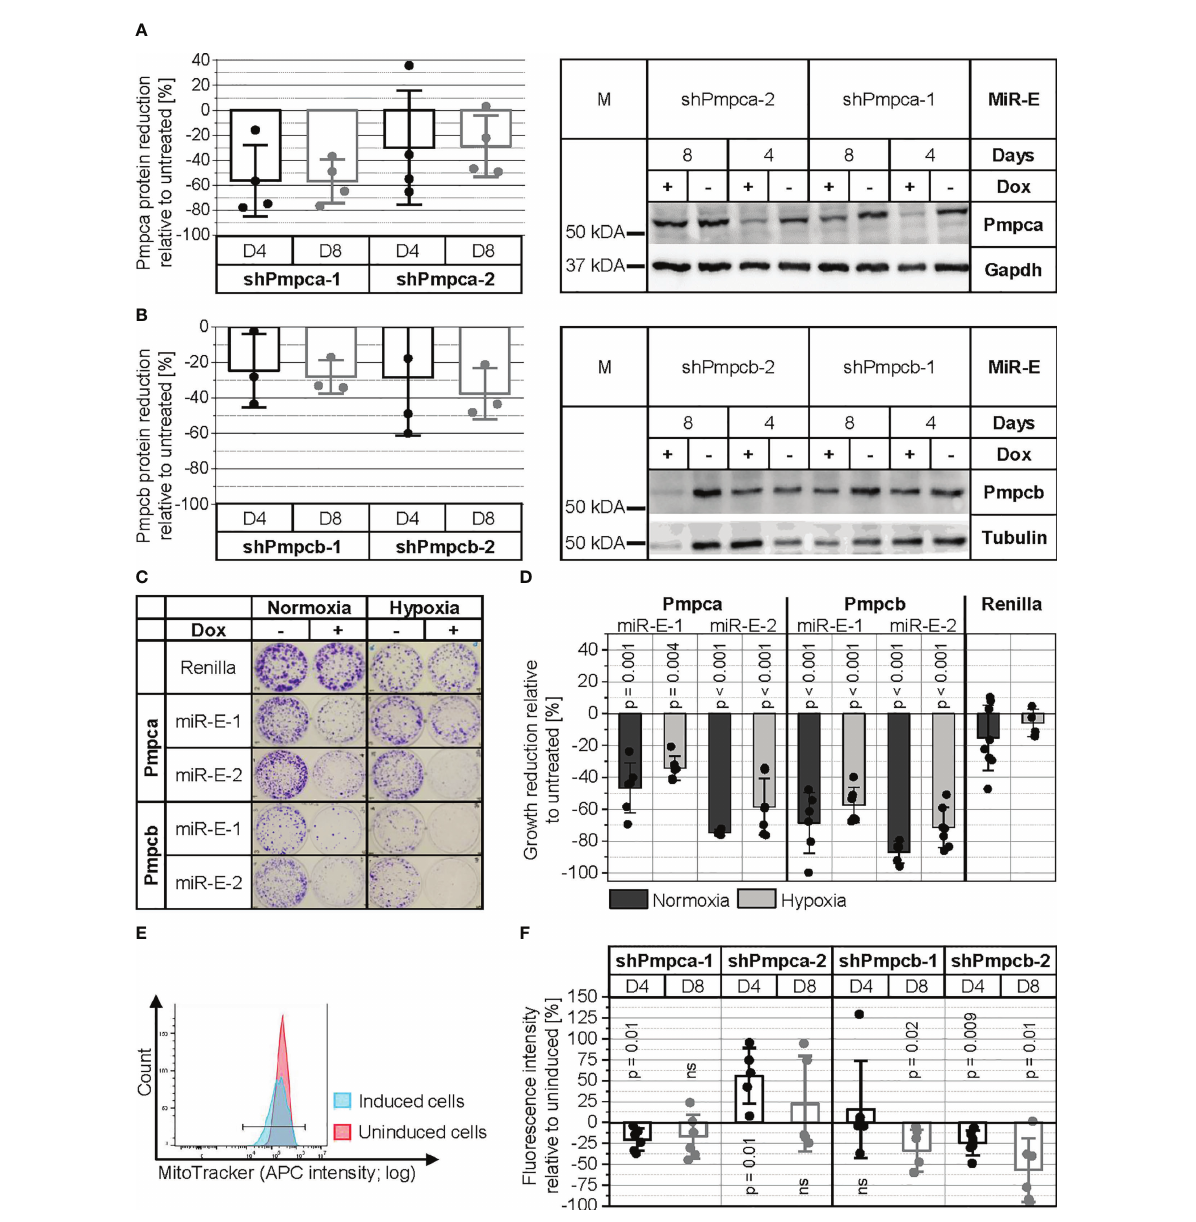
FIGURE 7 MPP is important for PyB6-TA cells. For simpli fi cation, miR-Es are indicated by sh. (A, B) Analysis of Pmpca (A) and Pmpcb (B) protein expression by Western blot in miR-E-transduced PyB6-TA cells cultured for 4 (D4) or 8 days (D8) ± Dox. Left: Quanti fi cation of Western blot data; mean reduction of protein level ± SD relative to uninduced cells normalized to tubulin or GAPDH. Right: Representative Western blots; tubulin or GAPDH as loading control; 25 µg protein loaded. M: marker. (C, D) Plate colony formation assay of miR-E-transduced PyB6-TA cells cultured ± Dox under normoxic conditions (21% O 2 , 8 – 9 days) or hypoxic conditions (3% O 2 , 12 – 14 days). ShRenilla-transduced cells as control. (C) Exemplary pictures. (D) Average cell growth reduction ± SD relative to untreated. Signi fi cance (p) one-sample t-test to 0 or two-sample t-test, equal variances assumed (n = 5 – 9). (E, F) Flow cytometry-based analysis of mitochondrial activity in miR-E-transduced PyB6-TA cells cultured for 4 or 8 days ± Dox by deep Red FM MitoTracker staining. (E) Exemplary median APC intensity. (F) Median APC fl uorescence intensity ± SD relative to uninduced. Signi fi cance (p): one-sample t-test to 0 (n = 5 – 6). Ns, not signi fi